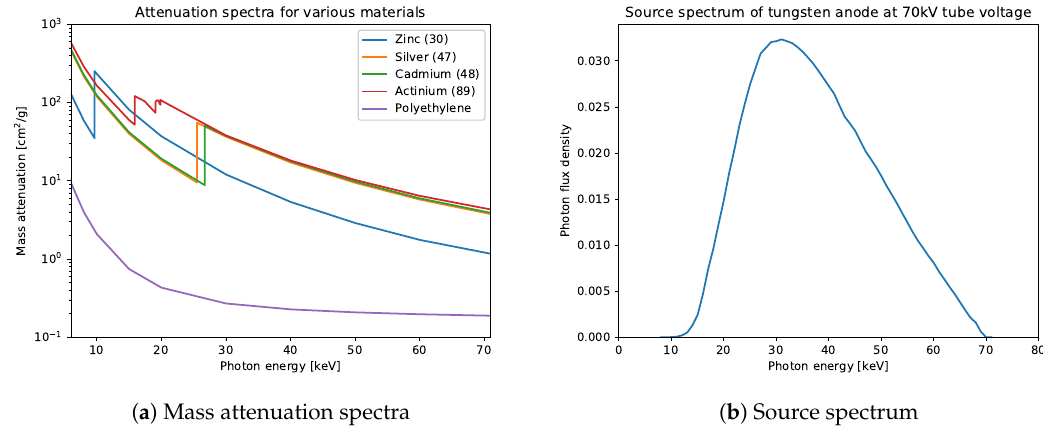
Figure 8. Mass attenuation spectra for zinc, silver, cadmium, actinium and polyethylene from 6 keV to 71 keV ( a ). In this spectral region, zinc, cadmium and actinium have one K-edge, polyethylene has none, while actinium has multiple edges. Note that the K-edges of silver and cadmium are relatively close to each other. This holds for all adjacent atomic numbers (not shown in this figure). ( b ) The normalized plot of the source spectrum I 0 used for generating the hyperspectral X-ray projections.